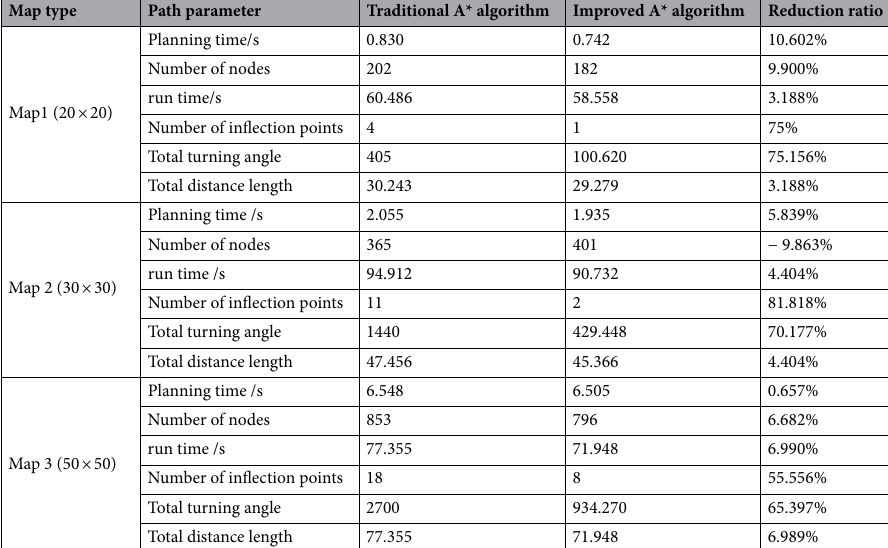
Table 3. Comparison of three kinds of grid map experiment simulation data.